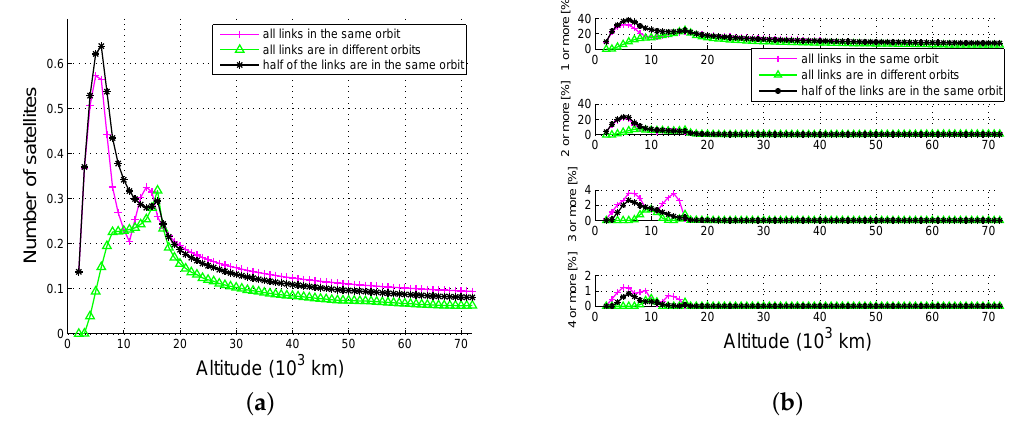
Figure 13. Availability as a function of link plan ( θ beam = 12 ◦ ): ( a ) number and ( b ) probability.